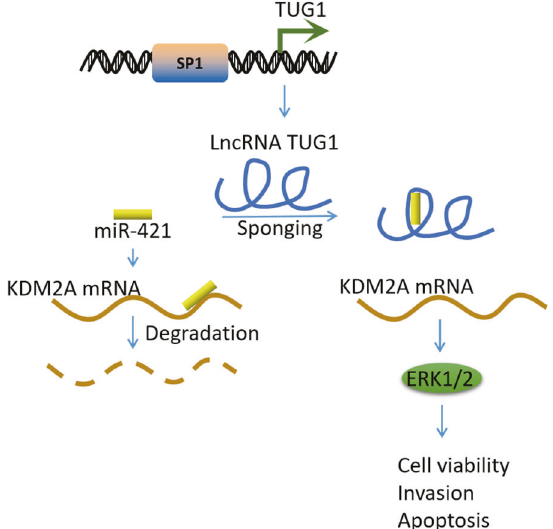
Fig. 7 Schematic diagram of the SP1-mediated oncogenic mechanism in CRC progression. TUG1, positively regulated by SP1, could bind to miR-421 to up-regulate KDM2A, thereby activating the ERK pathway and consequently enhancing CRC cell viability and invasion while repressing cell